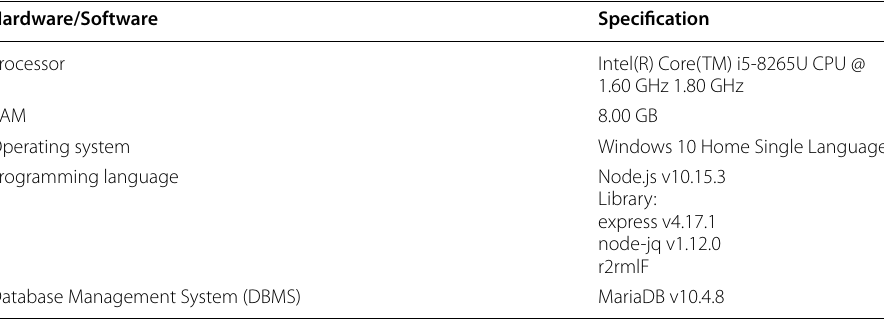
Table 7 Prototype development